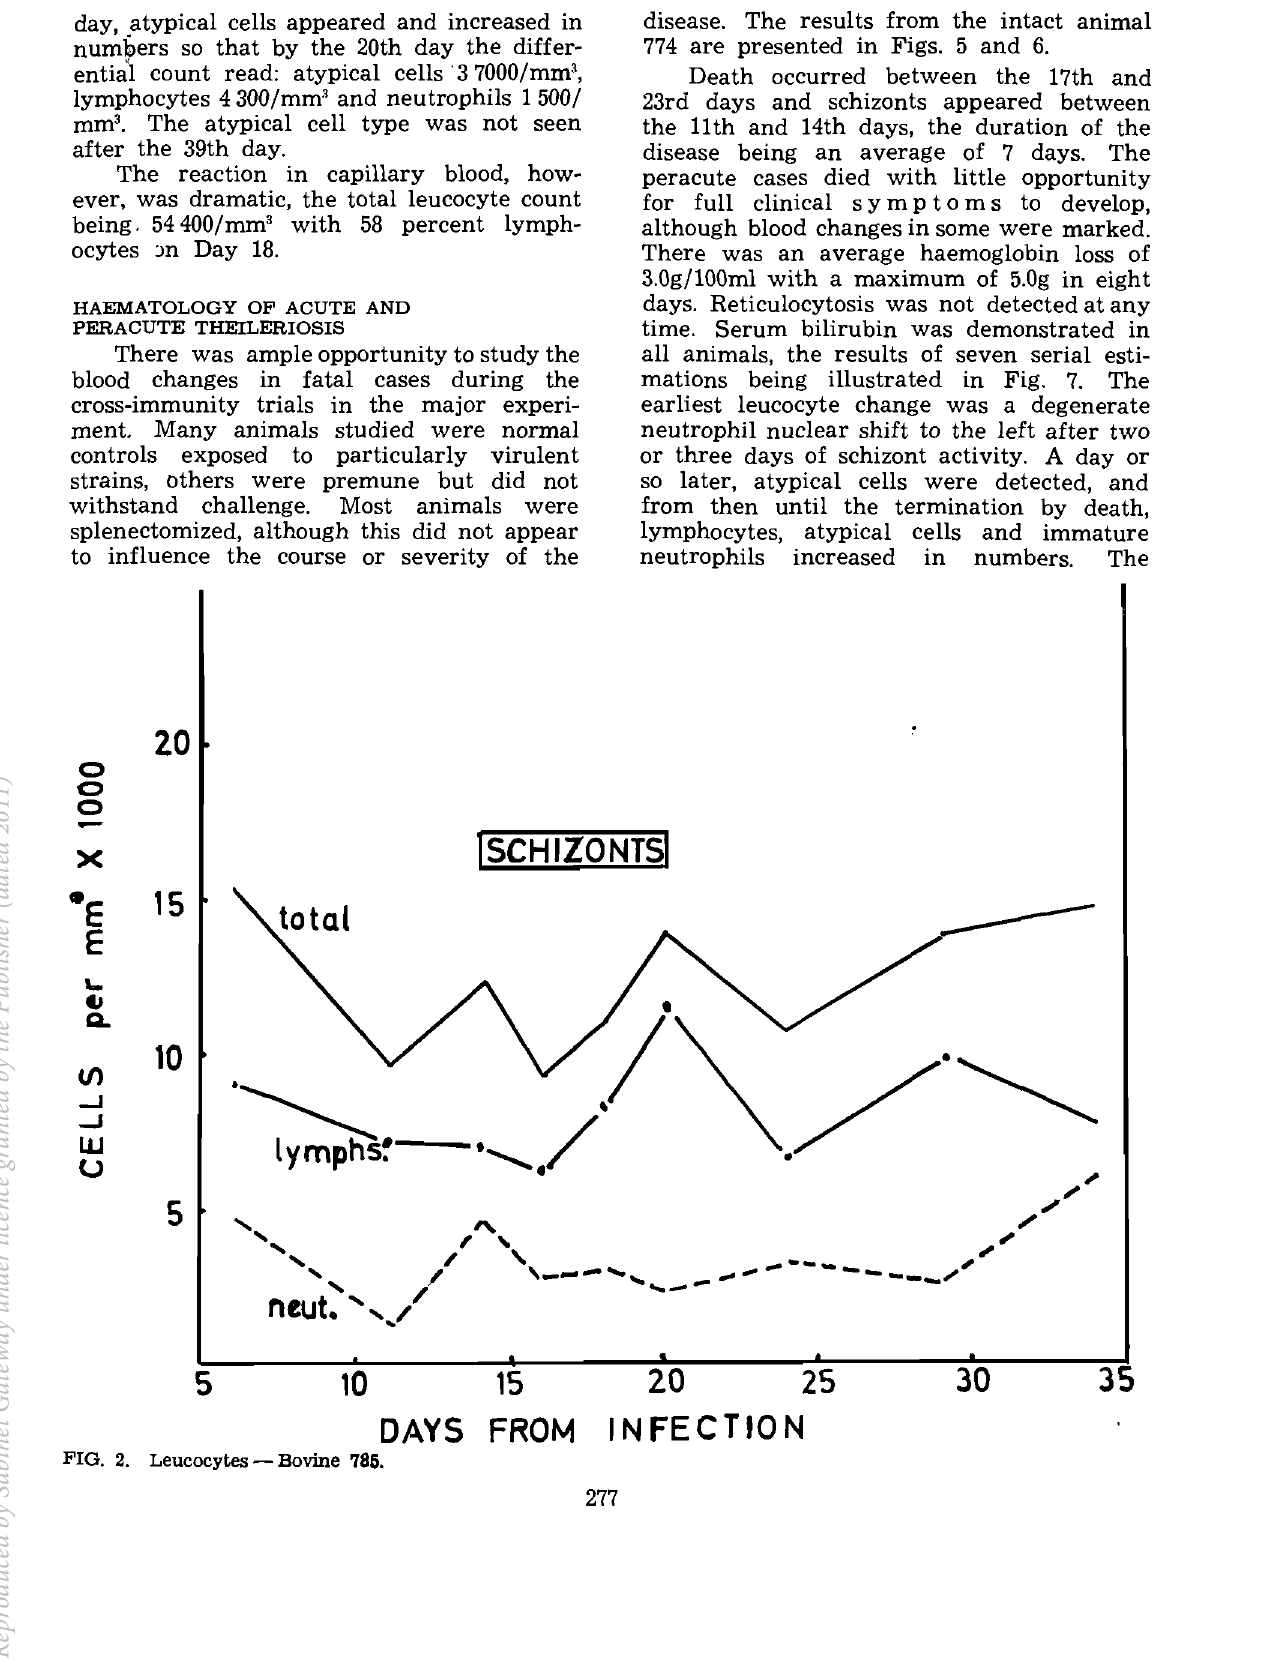
FIG. 2. Leucocytes - Bovine